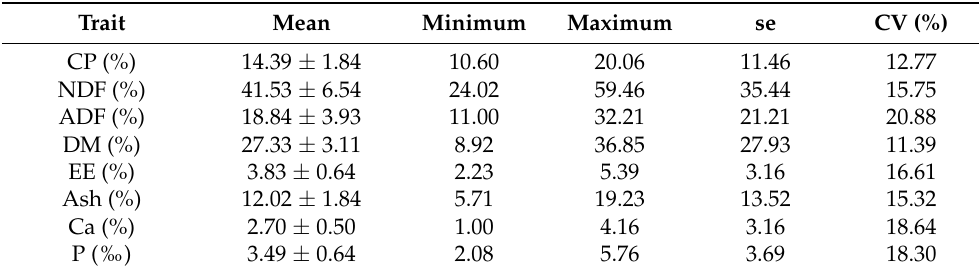
Table 3. Nutritional trait statistics for B. papyrifera